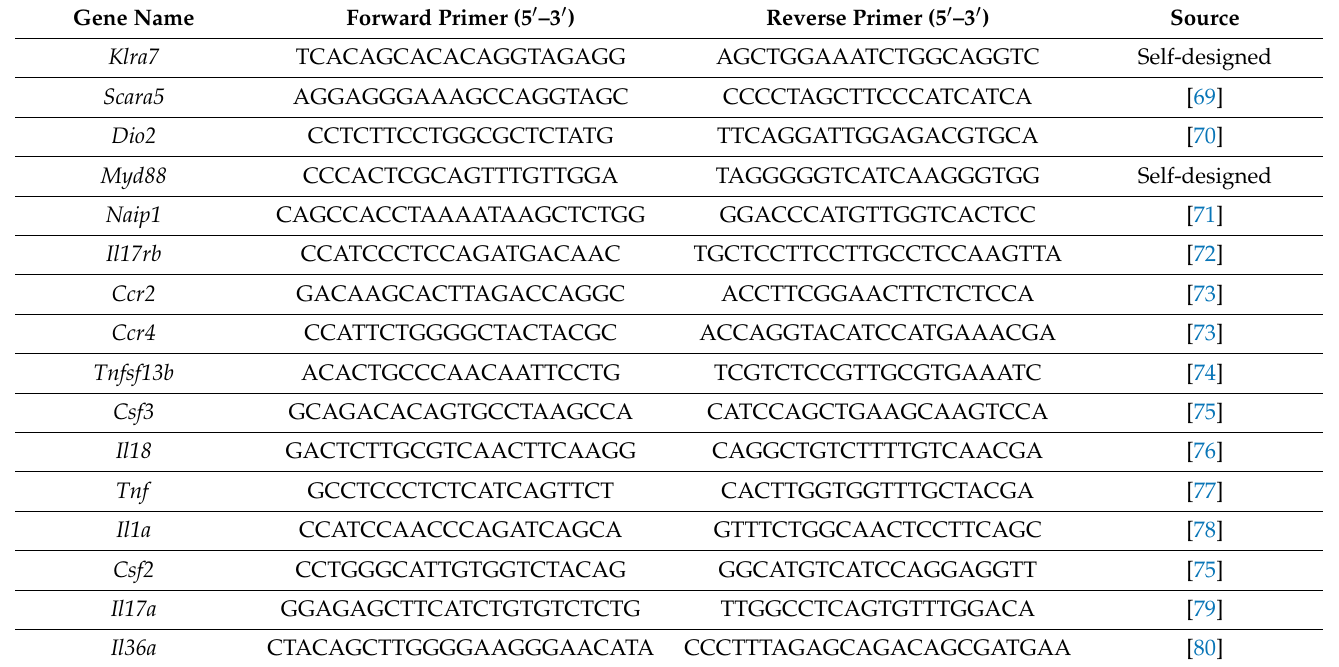
Table 1. SYBR green primers used for